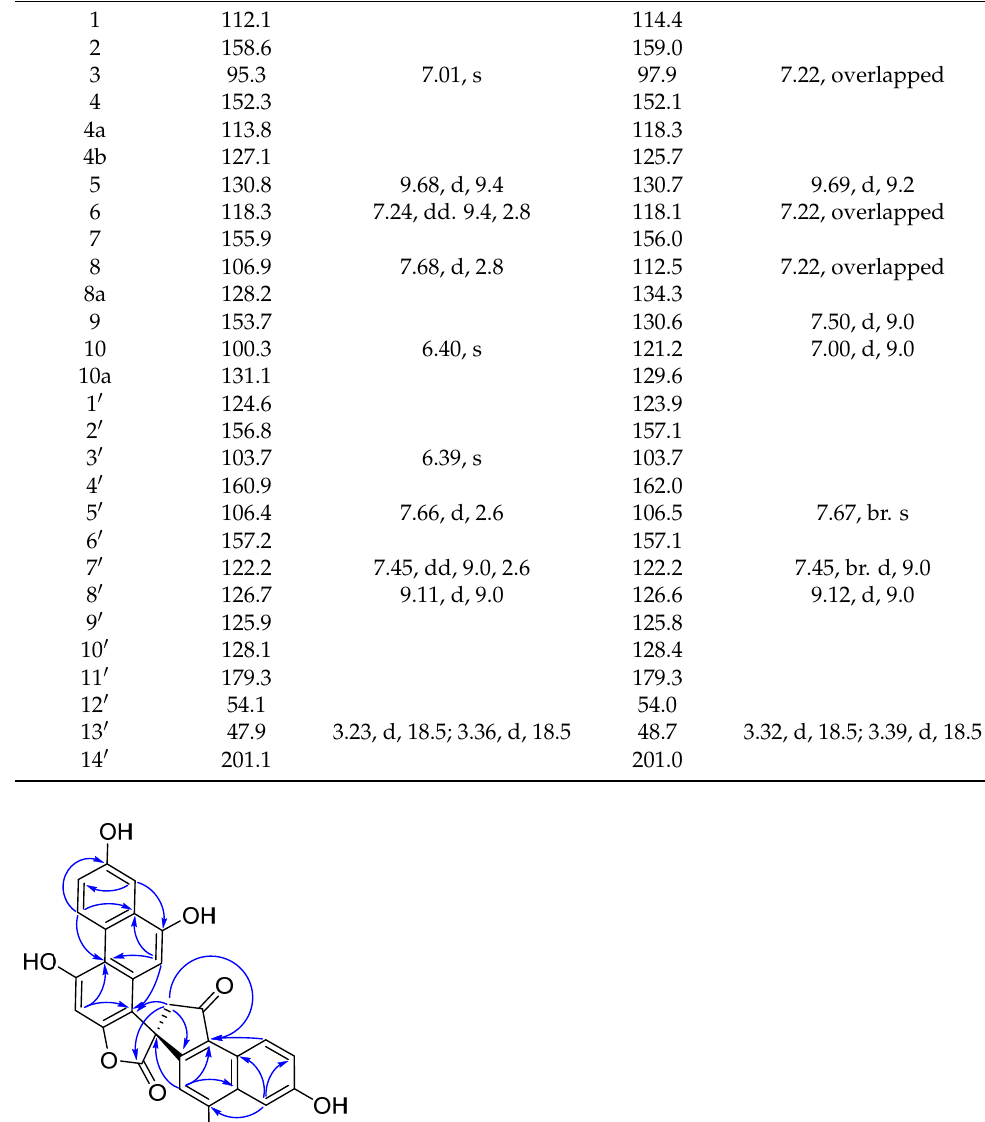
Figure 2. Selected HMBC correlations of 1. The blue arrows represent the nuclear magnetic relationship between two atoms.